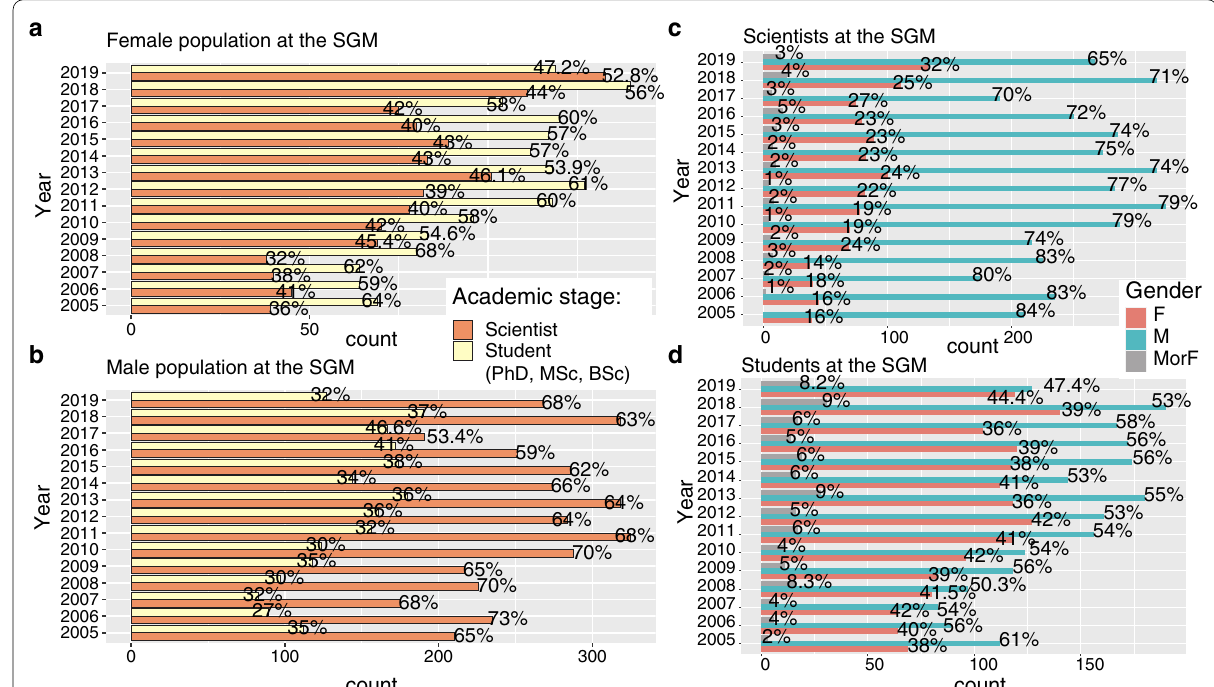
Fig. 3 Female ( a ) and male ( b ) attendance at the SGM since 2005, classified as student (BSc, MSc and PhD) or scientist. Scientist ( c ) and student ( d ) populations a the SGM since 2005, classified by